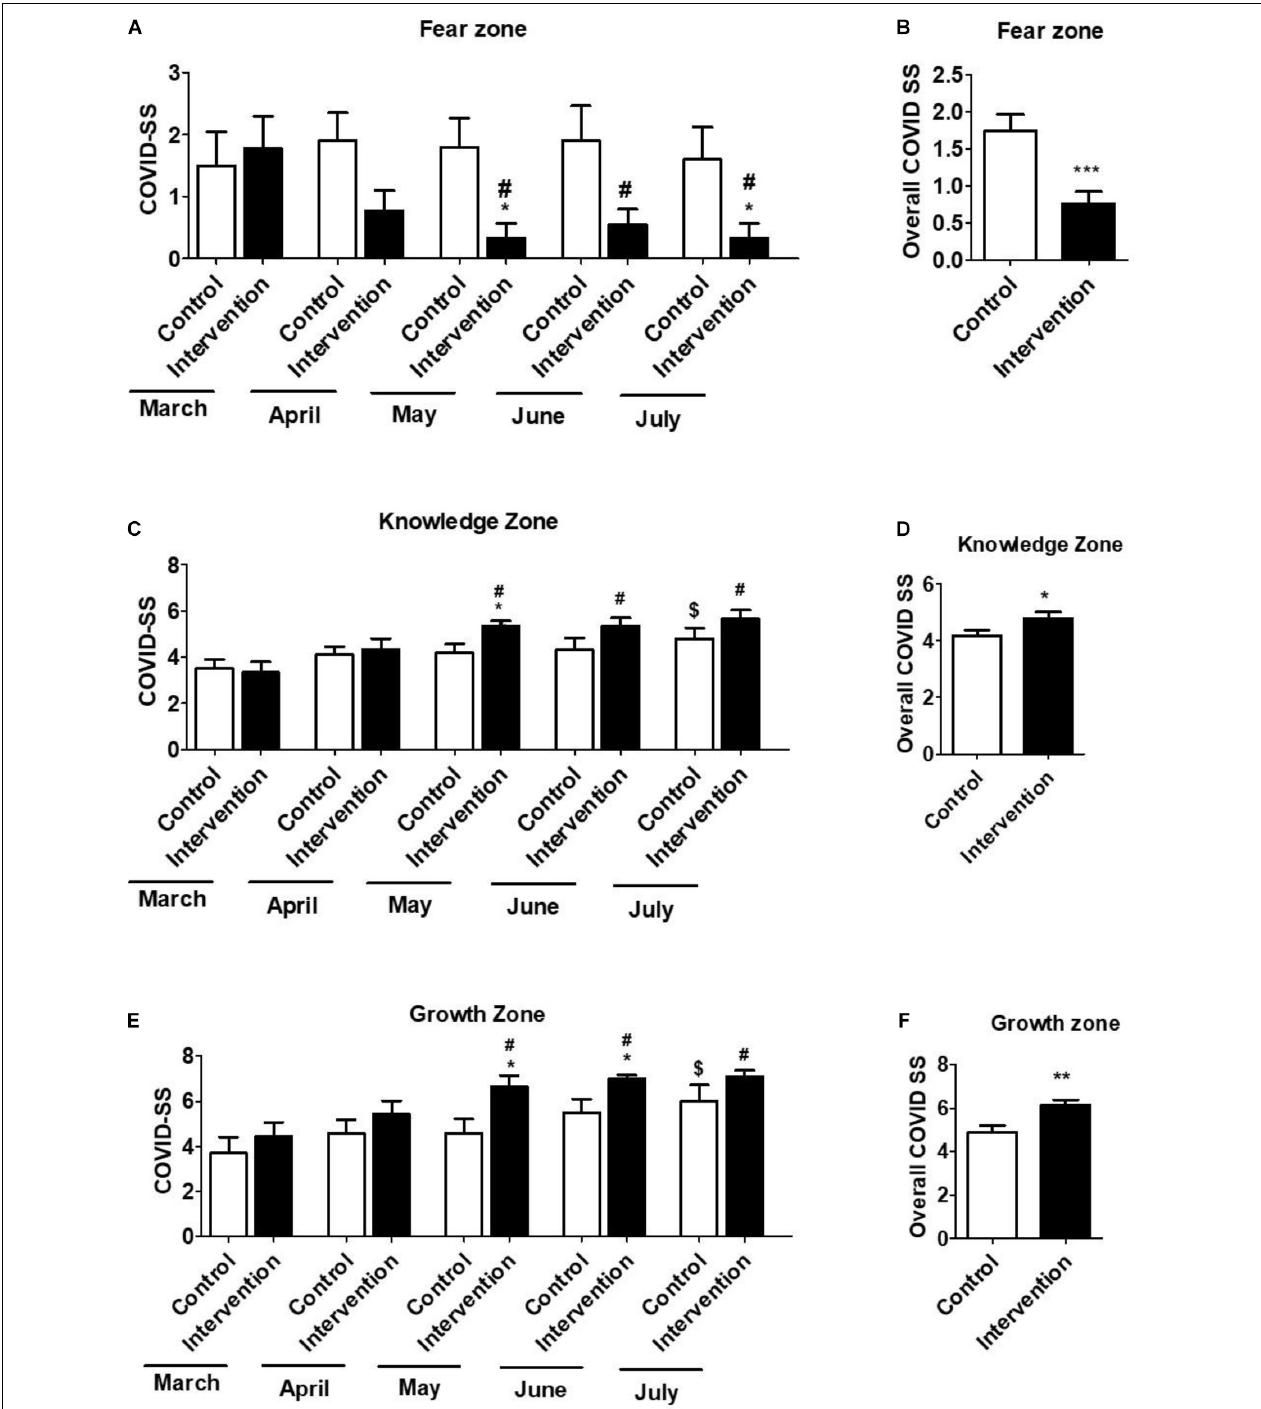
FIGURE 2 | The COVID-related stress score (COVID-SS) in the fear zone (A,B) , knowledge zone (C,D) , and growth zone (E,F) for March, April, May, June, and July were collected and compared between control ( n = 10) and intervention ( n = 9) groups. The scores of intervention and control groups in March were also compared to their respective scores of intervention and control groups in other months in each zone. The data in (B,D,F) represent Mean ± SD of overall COVID-SS scores of control ( n = 50, 10 subjects for 5 months) and intervention ( n = 45, 9 subjects for 5 months) groups. T -test was applied to compare the scores between months. p < 0.05, p < 0.01 are represented as “*” and “**” or “***”, respectively when compared the scores between intervention and control groups. “#” represents p < 0.05 when compared between intervention groups (March vs. other months). “$” represents p < 0.05 when compared between control groups (March vs. another